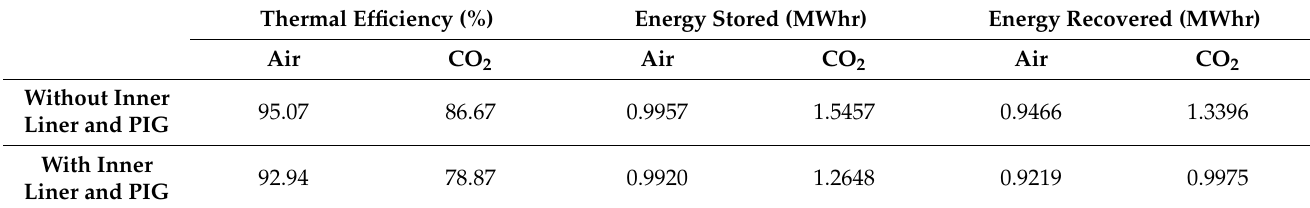
Table 9. Reduction influence of the inner liner and pipeline inspection gauge over the thermal efficiency, energy stored and recovered for air and CO 2